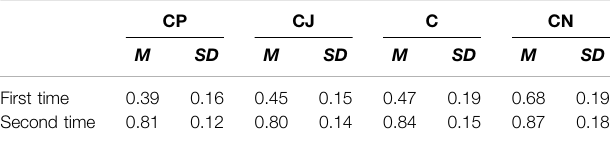
TABLE9| AllthecontrastsoftheperformancesofChinesewordandpicturepairs (CP), Chinese word and Japanese word pairs (CJ), Chinese words only (C), and novel Chinese words (CN) in learning condition retrieval tasks. Contrast Estimate